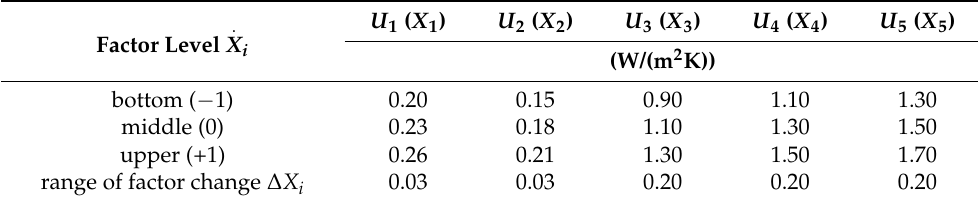
Table 5. Natural and standardized values of selected